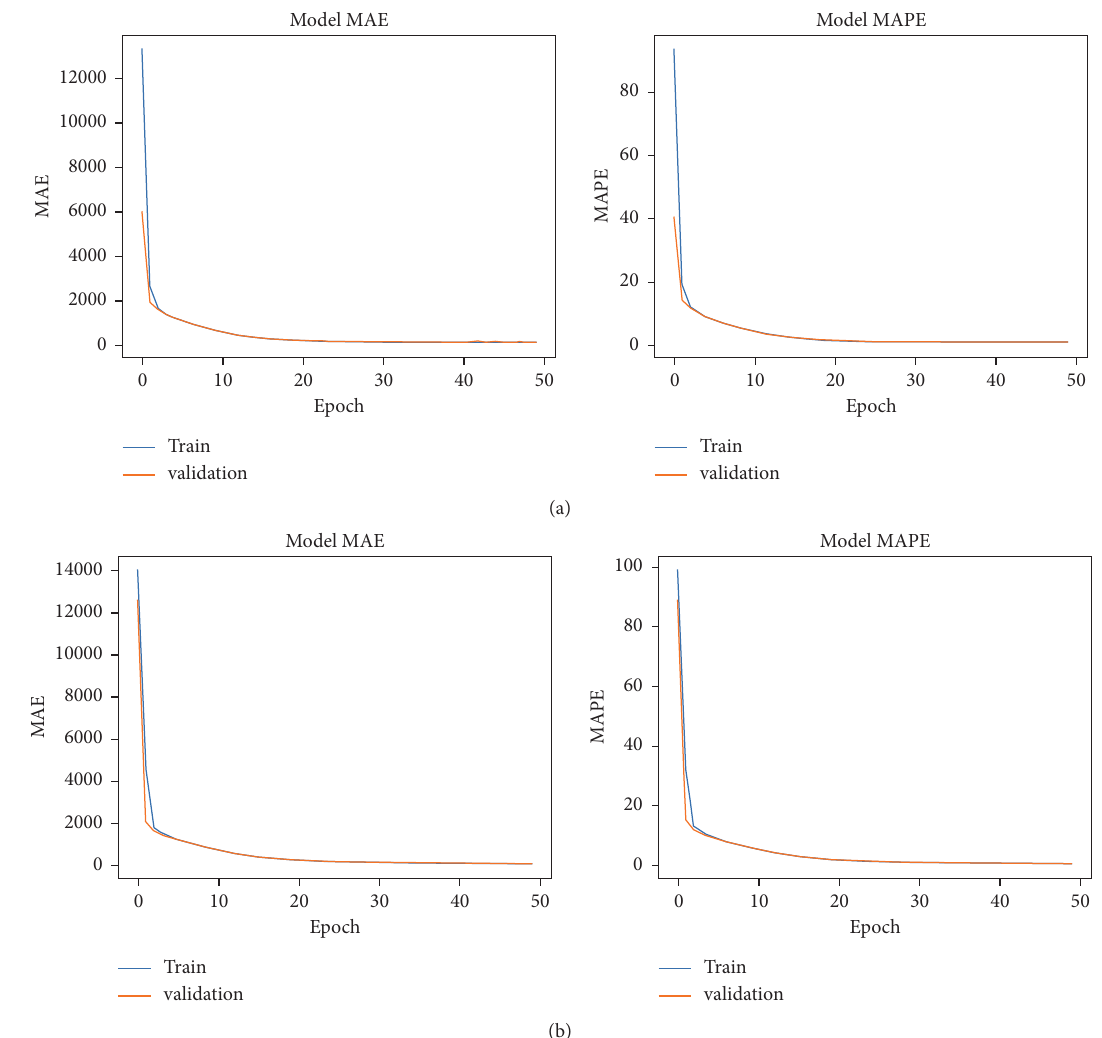
Figure 6: The learning curve of the CNN for the first time. (a) CNN model. (b) ANN